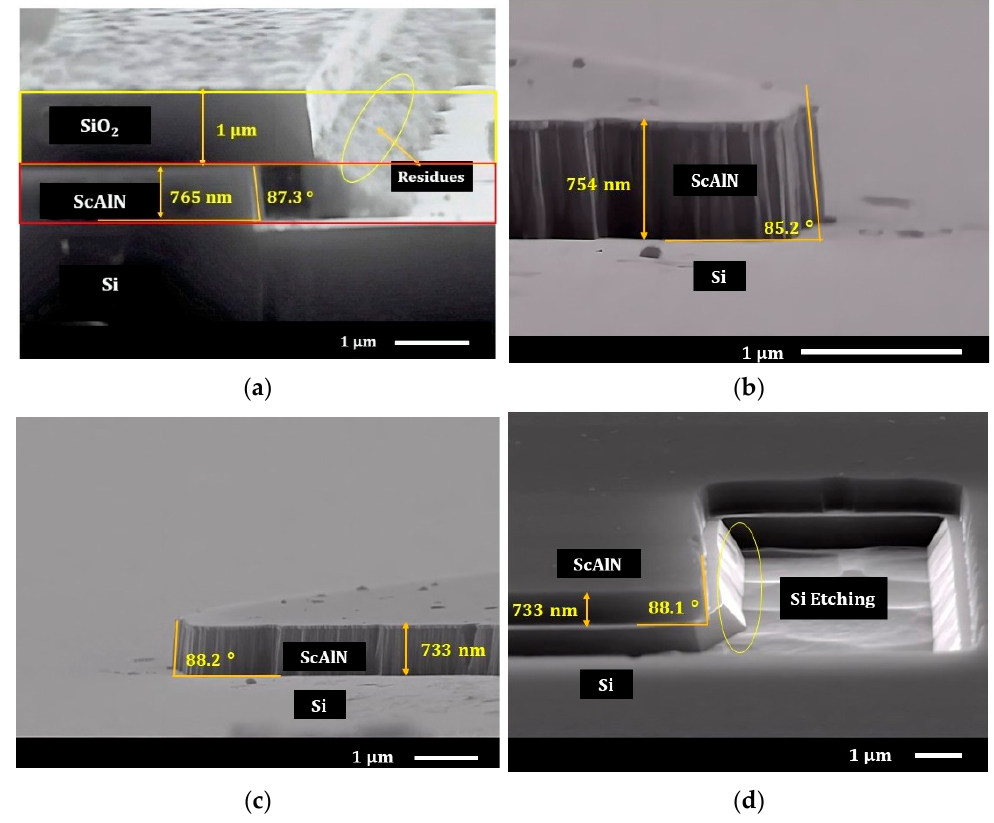
Figure 4. Scanning Electron Microscope (SEM) Images of ( a ) Sc 0.40 Al 0.60 N after 9 min of TMAH Etching at 80 ◦ C, ( b ) Sc 0.40 Al 0.60 N after Hard Mask (SiO 2 ) Removal, ( c ) Sc 0.125 Al 0.875 N after 2 min of TMAH Etching and Hard Mask (SiO 2 ) Removal, ( d ) Sc 0.20 Al 0.80 N Over etching condition (Silicon